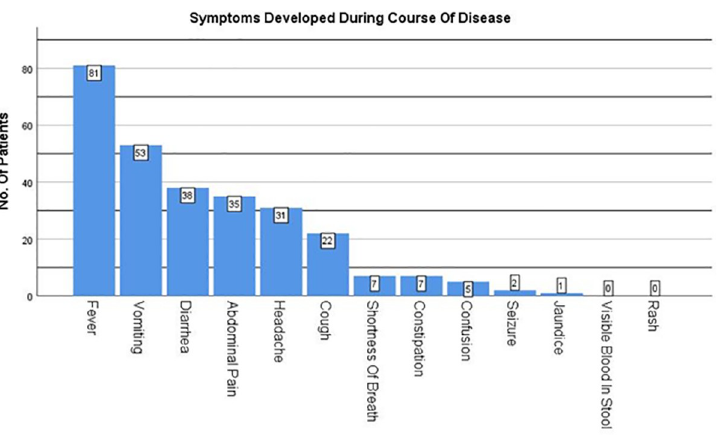
Fig 3. Presenting symptoms of patients at time of hospital encounter arranged in descending order of occurrence.